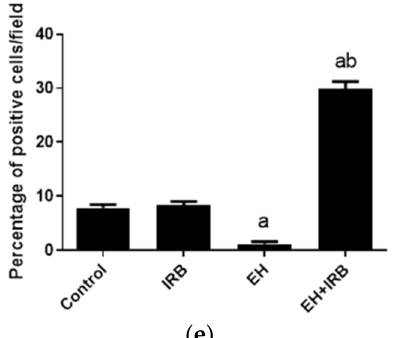
Figure 4. Effect of irbesartan (IRB) on uterine cleaved caspase 3 immunohistochemical staining in estradiol benzoate-induced endometrial hyperplasia (EH) and atypia in rats. Staining of cleaved caspase 3 in representative sections of rat uterus (×400) is shown in ( a ) control, ( b ) IRB-treated, ( c ) EH, and ( d ) EH+IRB-treated groups. Data in ( e ) show the results of the semiquantitative analysis of cleaved caspase 3 expression. Data represent the mean ± SEM ( n = 6–7) of the percentage of cleaved caspase 3 positive cells/field. a,b Significantly different ( p < 0.05) from control and EH groups, respectively.